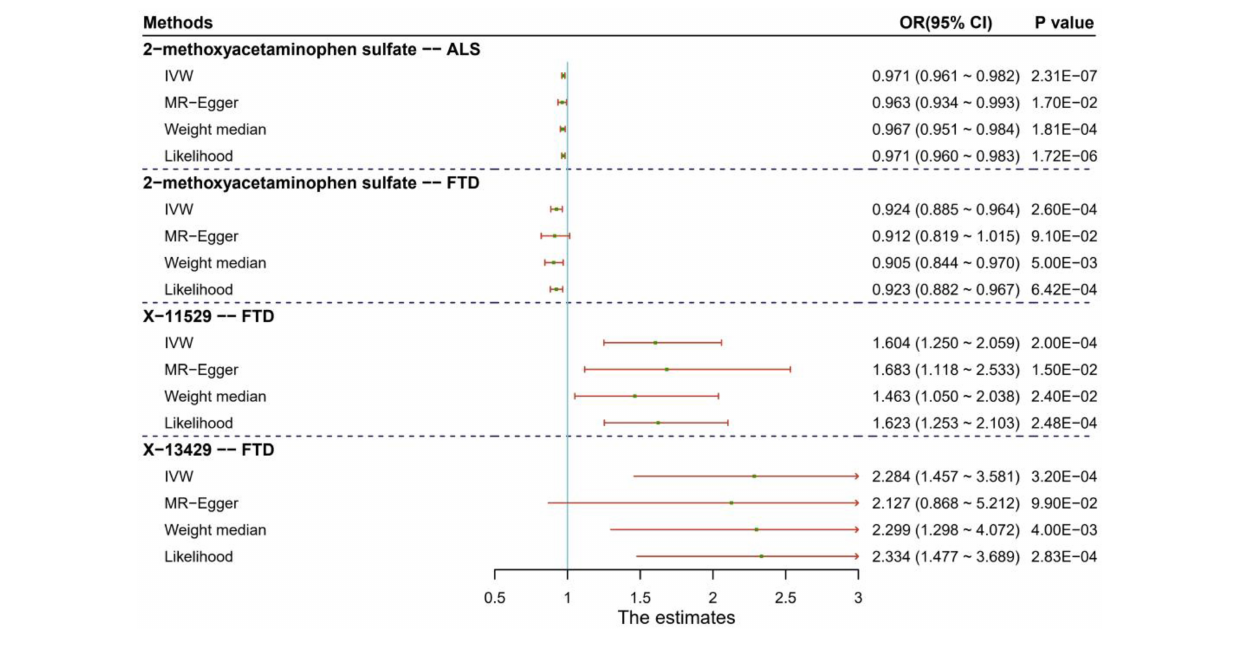
of horizontal pleiotropy ( P MR − PRESSO global > 0.05)